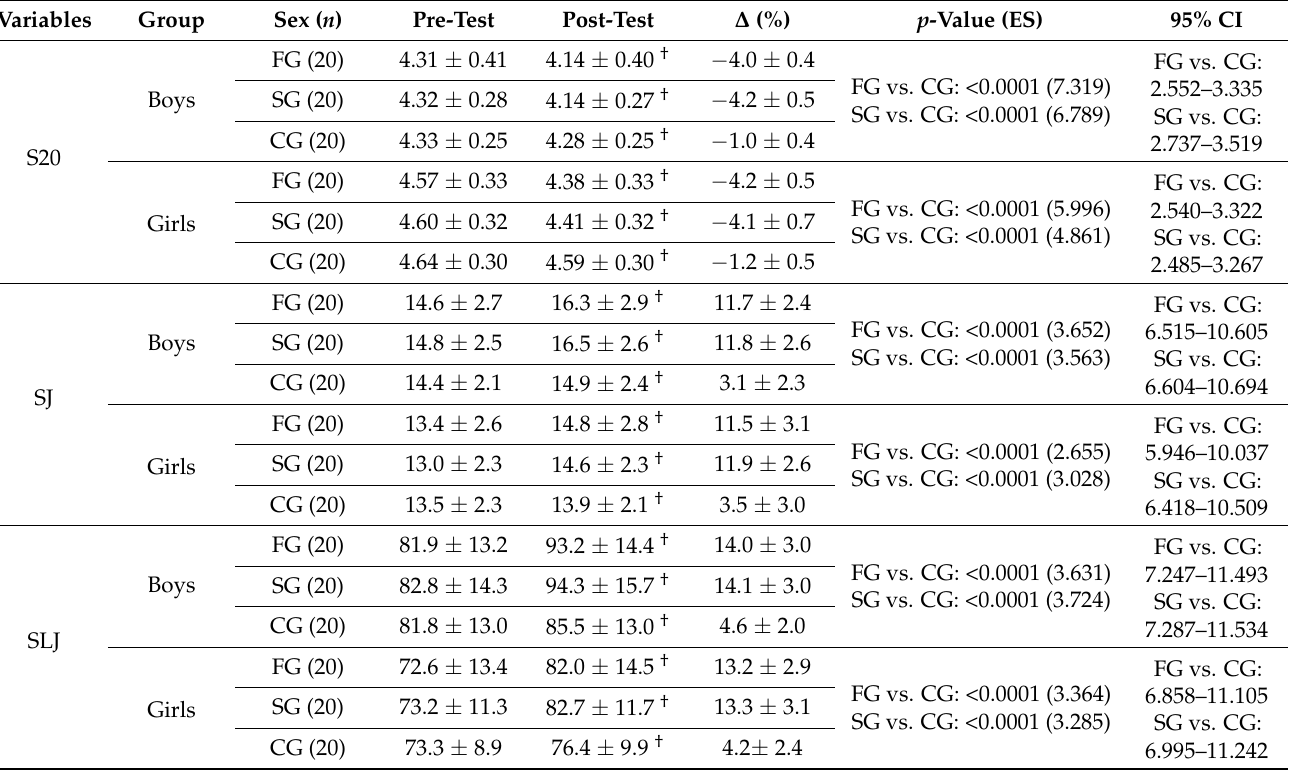
Table 3. Linear running speed (s) and jump (cm) performances at baseline and after the intervention period for all groups ( n =